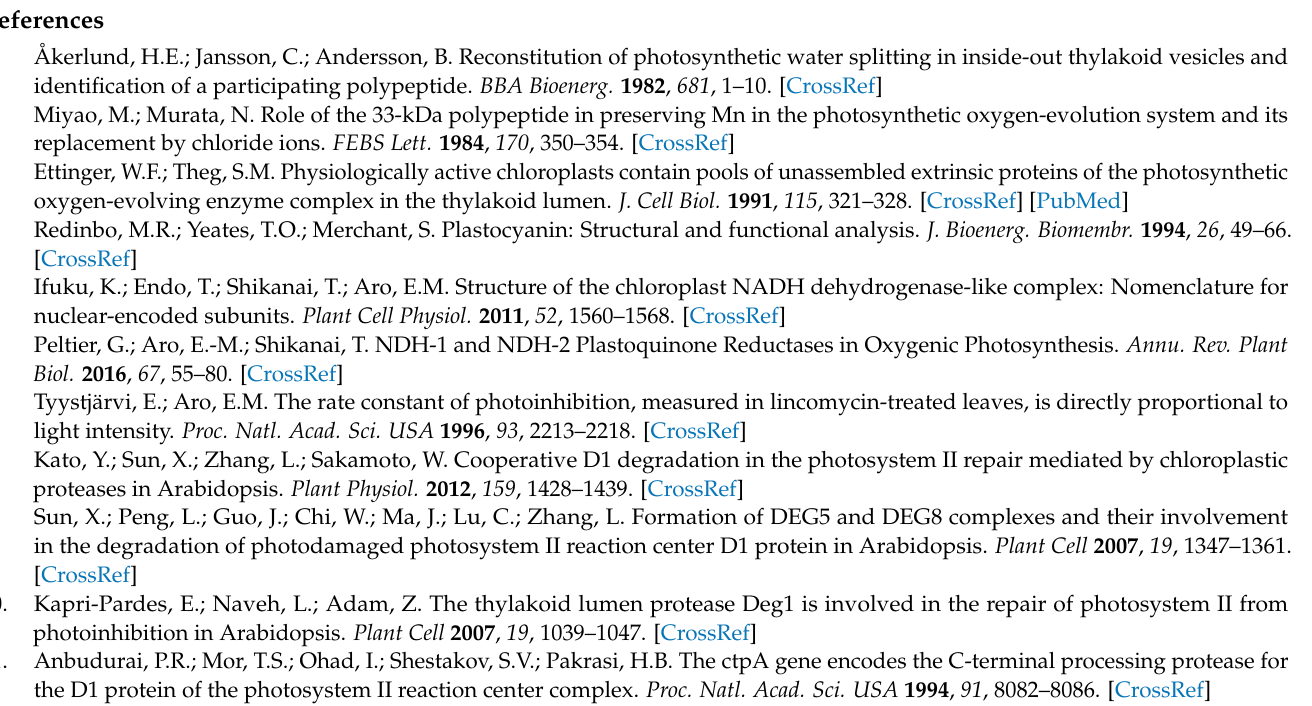
Table S1: List of identified proteins and related peptides in free lumen (FL) total soluble proteins analysis; Table S2: List of identified proteins and related peptides in membrane associate lumen (MAL) total soluble proteins analysis; Table S3: List of identified proteins and related peptides in 2D CN/SDS-PAGE spots from free lumen (FL); Table S4: List of identified proteins in the PsbO band and list of precursors and transitions used for detection and quantification in